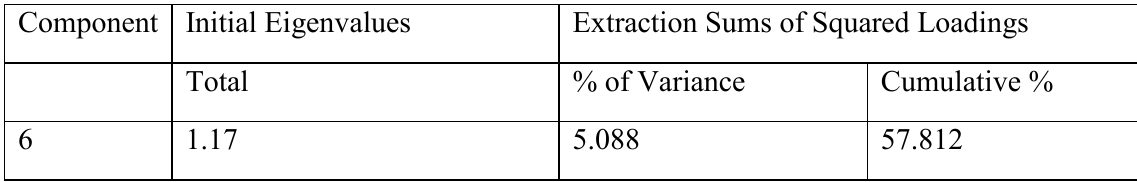
Table 1.49: Variance explained for Transformative Resilience PC6